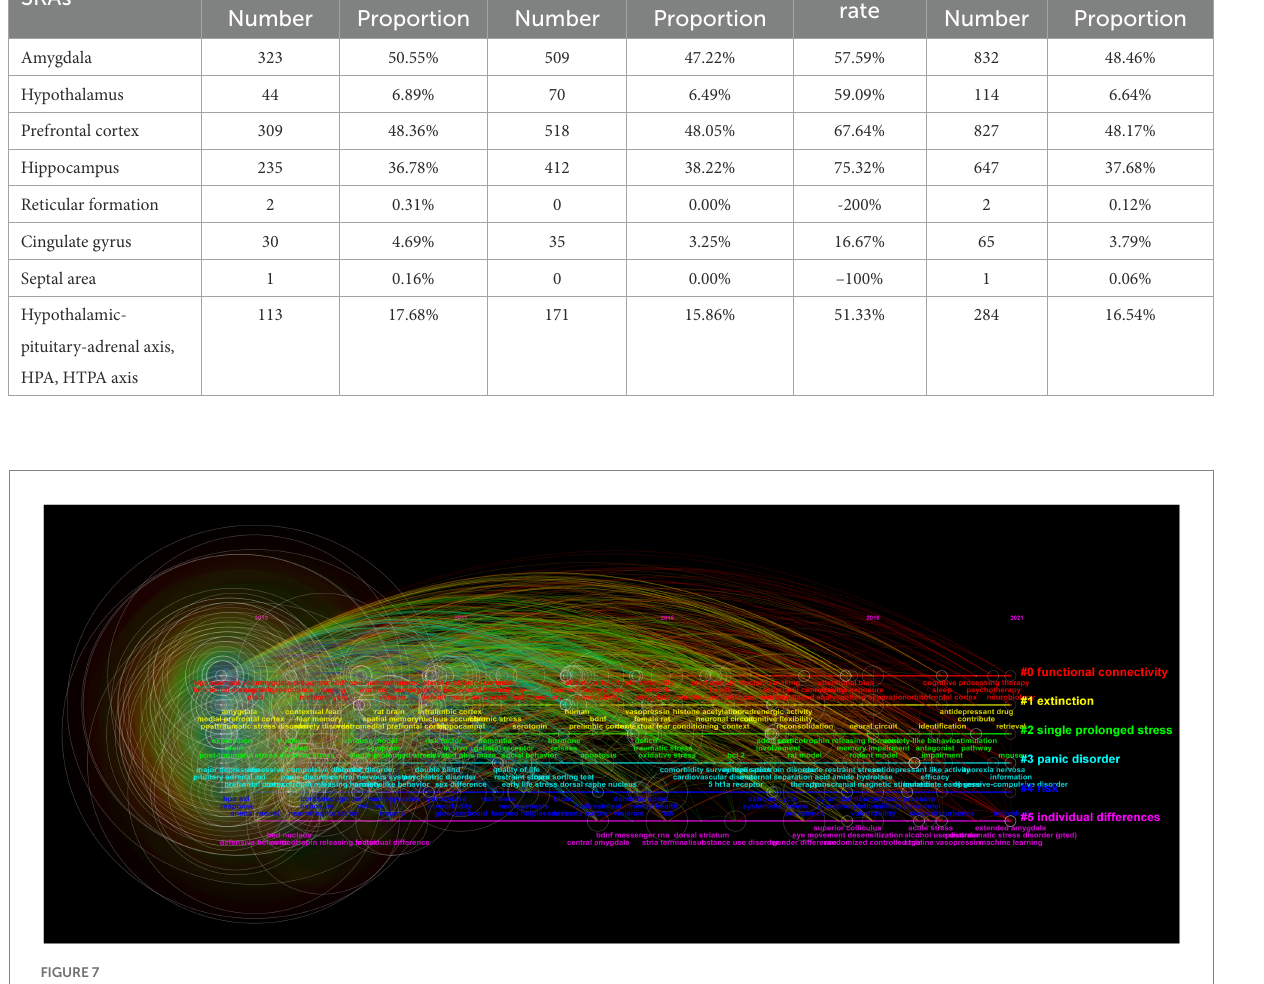
FIGURE 7 Time diagram of keyword clustering analysis of